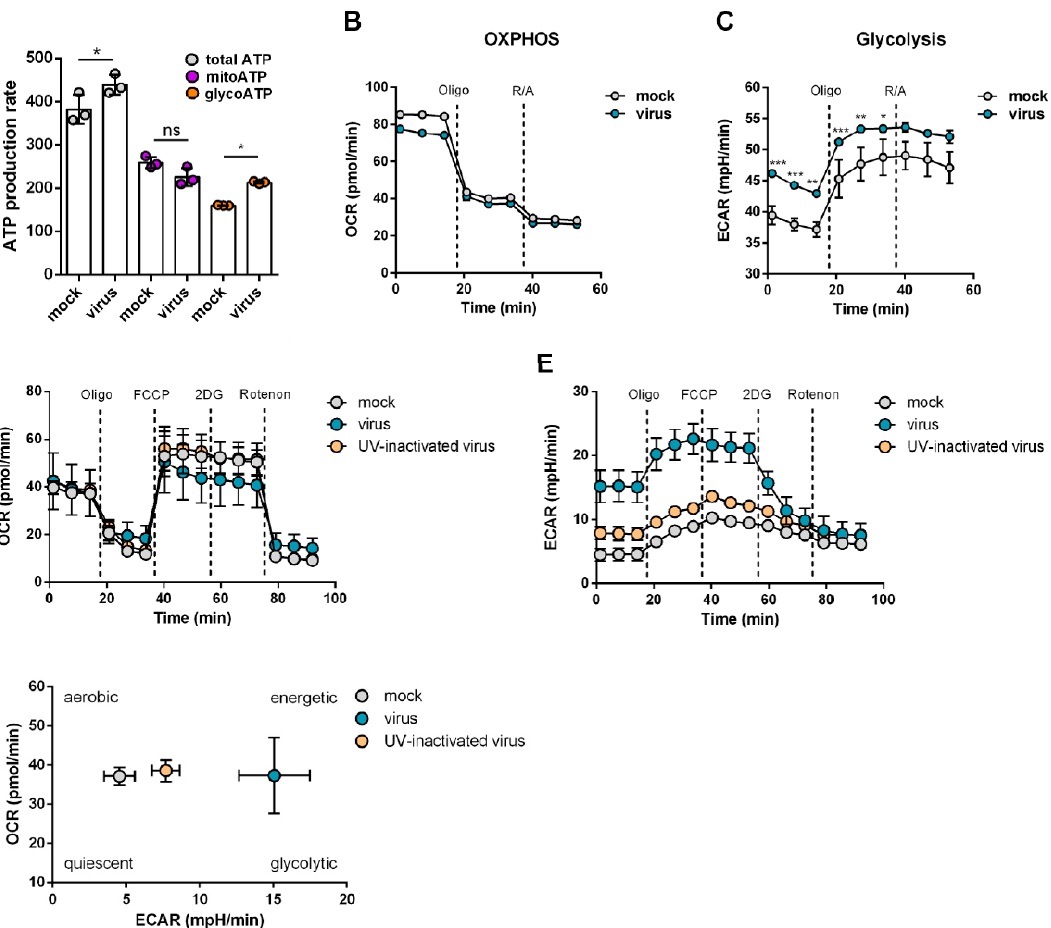
Figure 2. SARS-CoV-2 infection causes metabolic shift towards glycolysis. Caco-2 cells were infected with untreated or UV-inactivated SARS-CoV-2/FFM7 at an MOI of 0.01 for 24 h before measurement. ( A – C ) Pathway-specific ATP production ( A ) derived from mitochondrial respiration ( B ) and glycolysis ( C ) measurement. Mean + SD from three biological replicates are displayed. Statistical significance was determined through one way ANOVA. * p ≤ 0.05, ** p ≤ 0.01, *** p ≤ 0.001, ns: not significant. ( D – F ) Measurement of mitochondrial respiration and glycolytic function under stress conditions (Mito stress Test). Mean + SD from three biological replicates are displayed. ECAR, extracellular acidification rate; OCR, oxygen consumption rate.